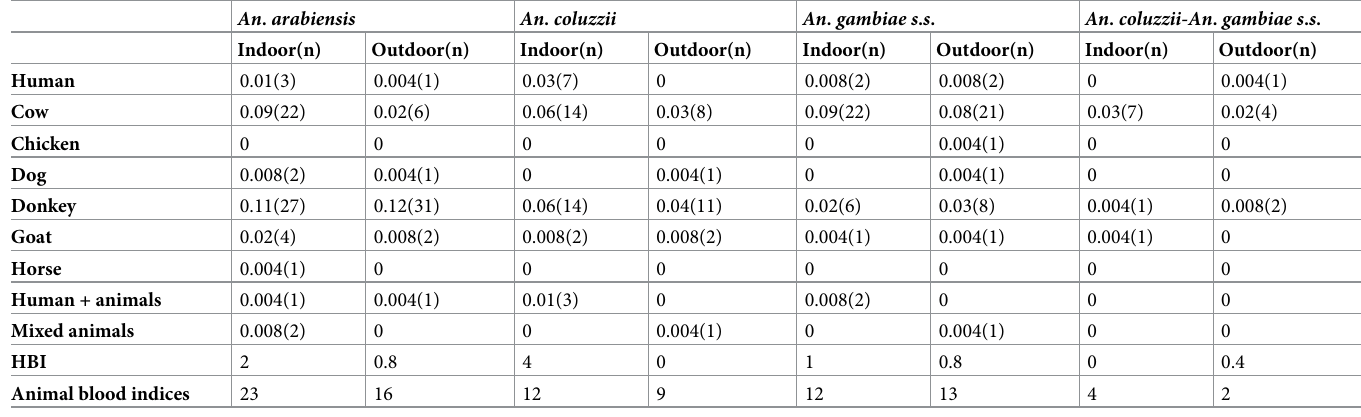
Table 3. Human and animal blood meal preferences of the indoor and outdoor-resting vector species in combined study